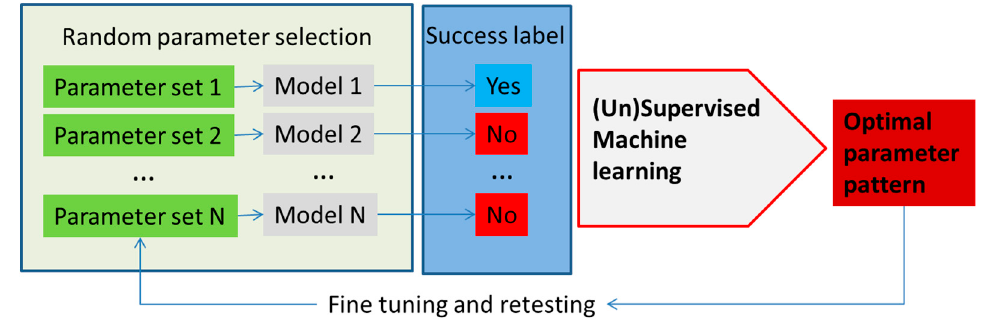
Figure 3. An outline of the utilization of machine learning methods in metabolism modeling application for optimization of parameters in the model, as well as testing different input conditions. In this example, parameters in the model are selected at random (e.g., using Monte Carlo sampling) or, alternatively, reactions are taken out or put in (in the constraint-based models) and the models are run. The success of each model is determined using the parameter of interest (e.g., cell growth or cell death, production of the molecule of interest, etc.). Model parameters (1–N) are used as feature vectors with the success label used as the class label in the machine learning classifier. The classifier determines patterns in the parameter space with the highest discriminatory power that ensures success according to the model.